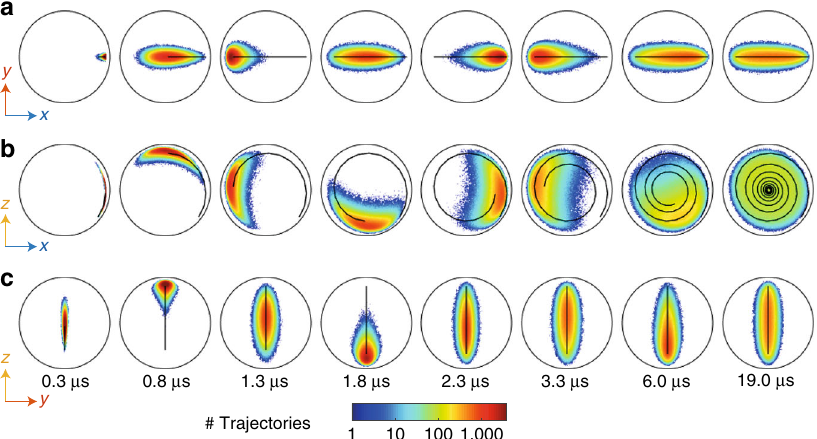
Fig. 4 Evolution of the distribution of quantum states. a – c Colored dots: each frame represents the marginal distribution, in the x − y ( a) , x − z ( b) , and y − z ( c) planes of the Bloch sphere, of the states of the qubit at a given time τ for 1.5 million realizations of the experiment, in the same experimental conditions as Fig. 2a. Each state ( x , y , z ) is reconstructed from the measurement records { u ( t ), v ( t ), w ( t )} for time t between 0 and τ using Eq. (3). Time τ is increasing from 0.3 to 19 μ s from left to right as indicated at the bottom of the fi gure. For each fi gure, the surrounding black circles represent the pure states of the plane (e.g. z = 0 for a ). Solid lines: average projection of all 1.5 million quantum trajectories { x ( t ), y ( t ), z ( t )} for 0.2 μ s < t < τ